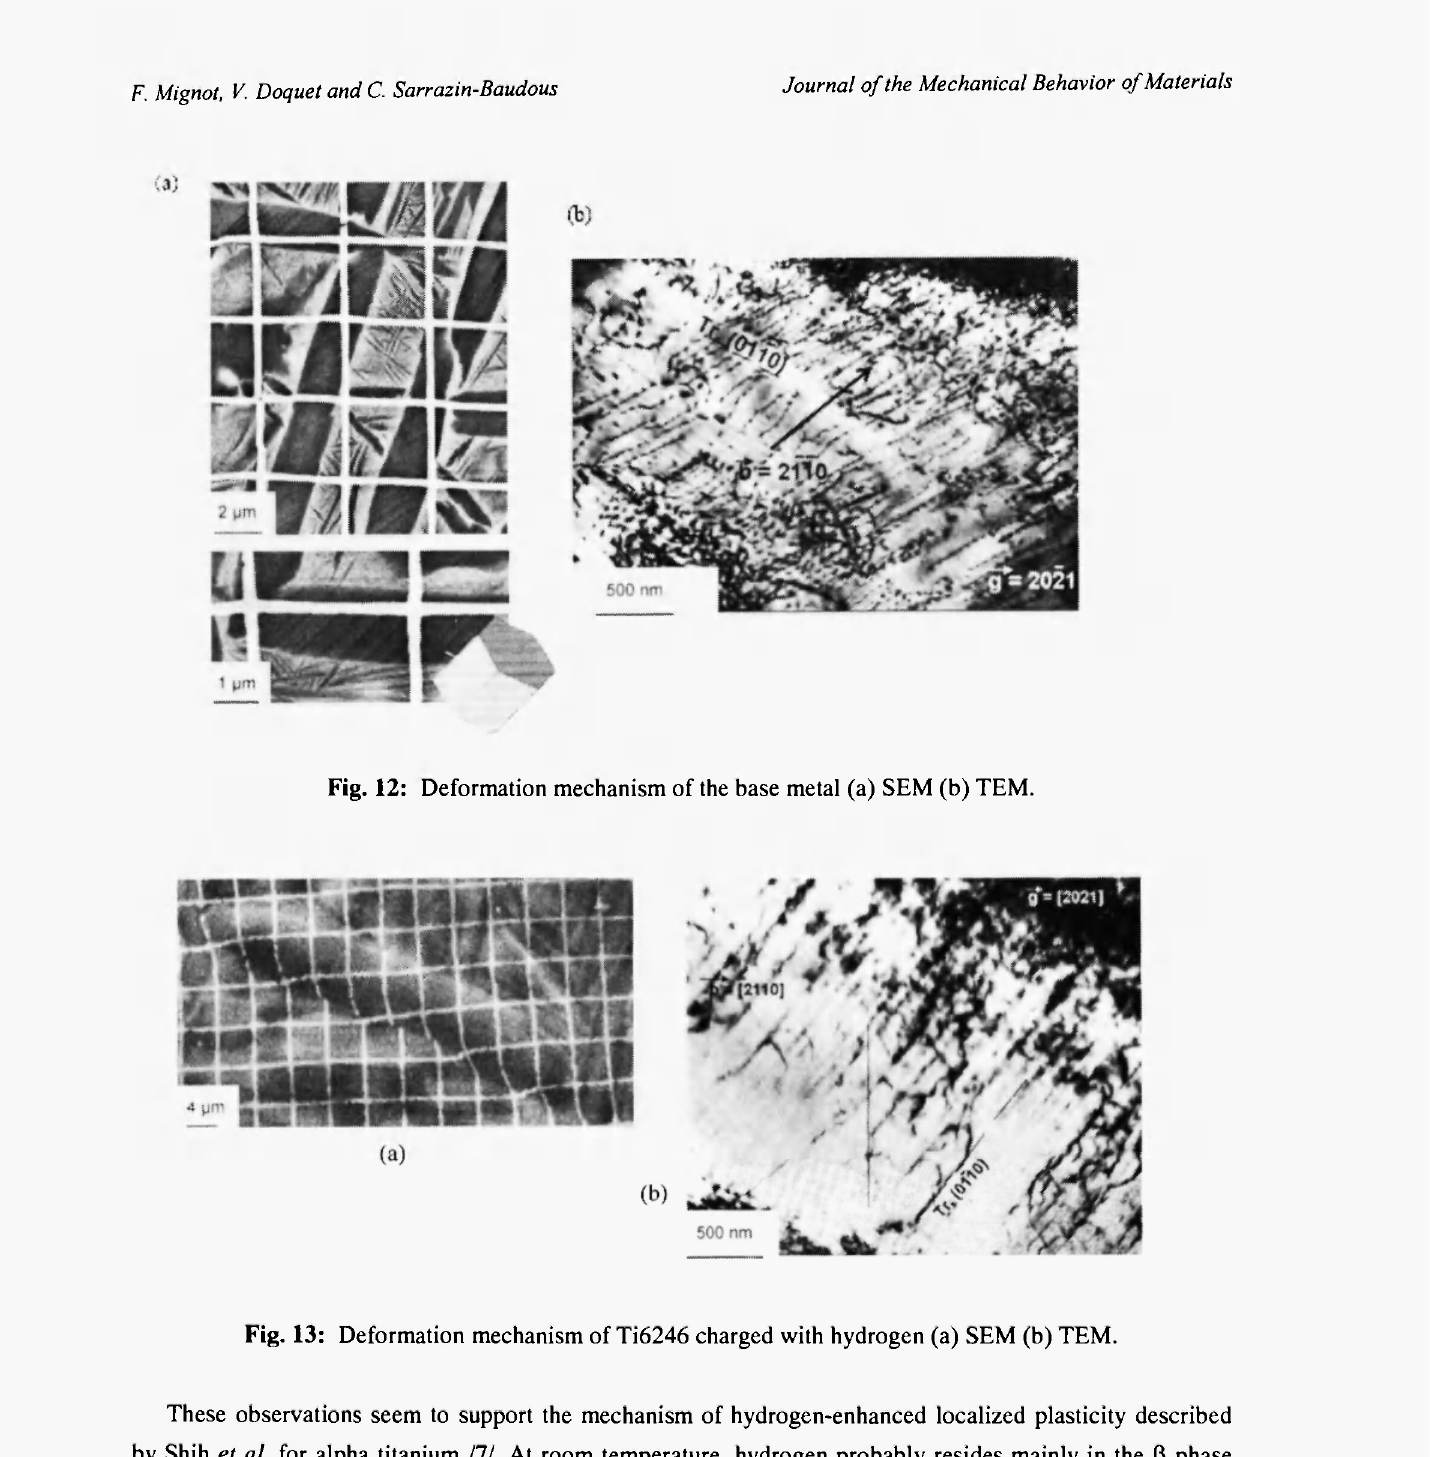
Fig. 13: Deformation mechanism of ΤΪ6246 charged with hydrogen (a) SEM (b)